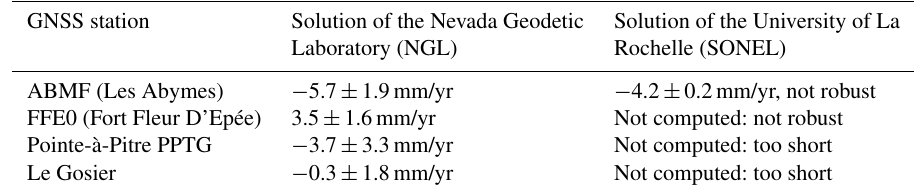
Table 2. Trends obtained from the two GNSS stations located close to